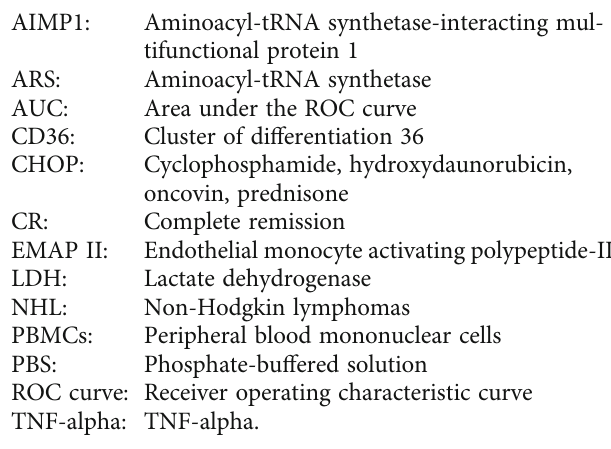
Supplementary Table 1: c omparison between NHL patients and healthy control as regards demographic data. Supple- mentary Table 2: Percentage of EMAP II in peripheral blood cells in Non-Hodgkin ’ s Lymphoma (NHL) patients and healthy controls. Supplementary Table 3: percentage of EMAP II in peripheral immune cells in 5 T-NHL patients. Supplementary Table 4: comparison of LDH levels between NHL patients. Supplementary Figure 1: gating is used to detect cells for analysis. (Supplementary